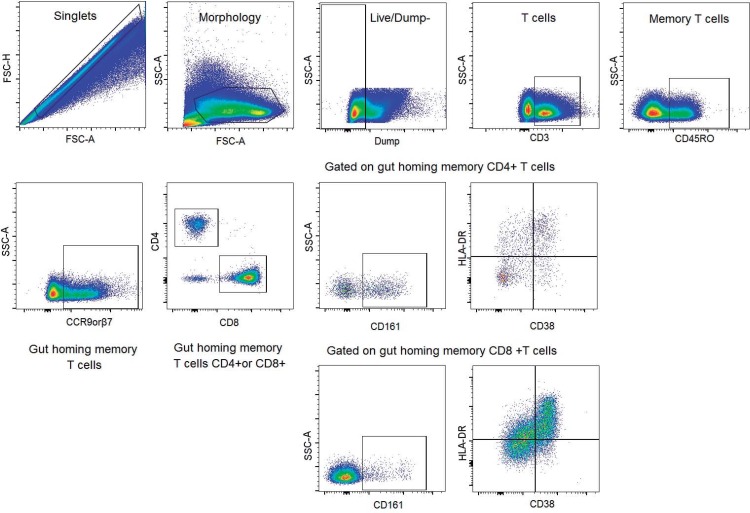
Gating strategy.The gating strategy used for all the samples was to first define singlet and morphology by using forward versus side scatter, followed by the exclusion of dead cells (aqua dye negative events) and the exclusion of CD14, CD19, CD56, CD11c and CD123 positive cells (dump gate). Live cells were gated on CD3+ and CD45RO+ cells. Next, CCR9+ and/or β7+ cells were gated and defined as gut homing T-cells. Then CD4+ and CD8+ T cells were gated and finally the expression of CD161 on the gut homing CD4+ (top) and CD8+ (bottom) T-cells was gated. T cell activation was determined by the simultaneous expression of CD38 and HLADR on gut homing CD4+ and CD8+ T cells.